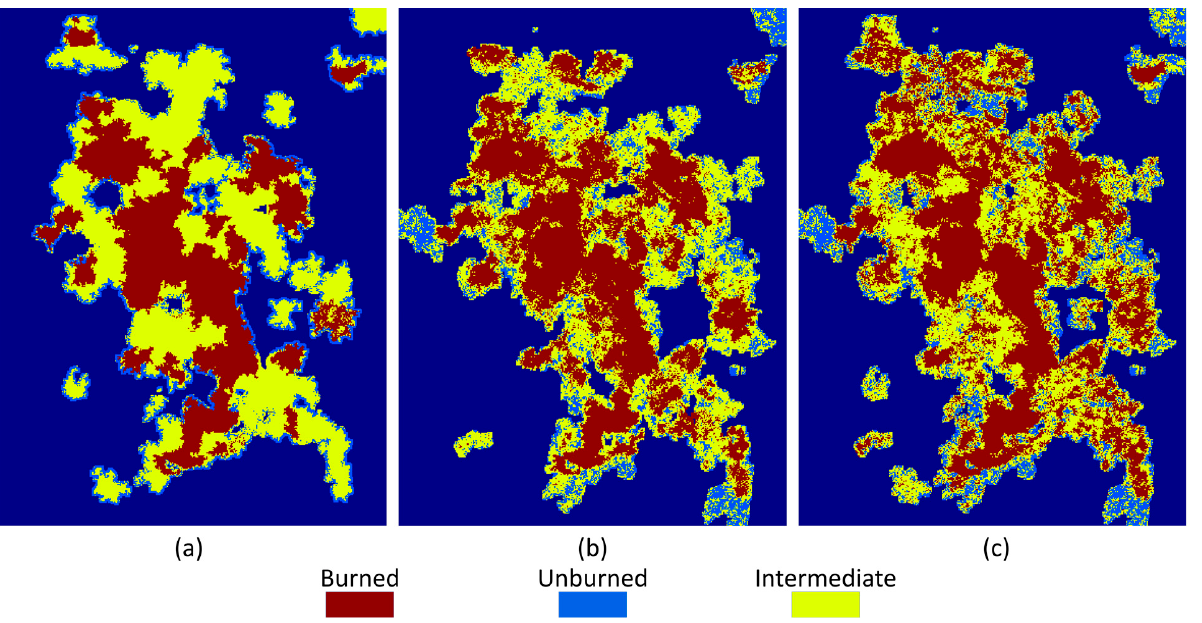
Figure 6. Clusters with a high and low probability of belonging to burned areas in the salient regions for ( a ) VV, ( b ) VH, and ( c ) both polarizations as FCM input.